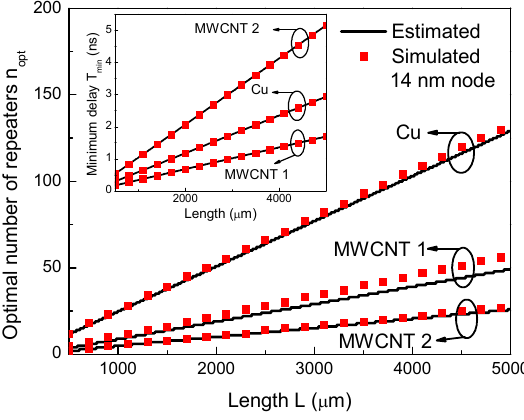
Figure 7. Propagation delays versus number of repeaters for 2000 ‐μ m ‐ long global ‐ level Cu and MWCNT interconnects. ( a ) Cu; ( b ) MWCNT 1; ( c ) MWCNT 2; and ( d ) MWCNT 3.